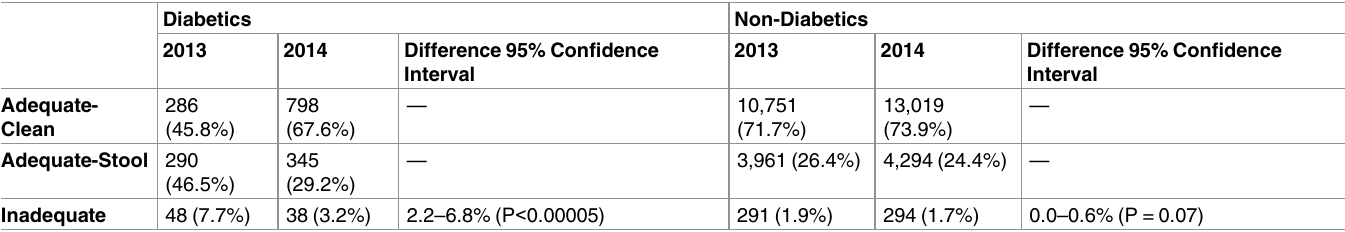
Other procedure outcomes for diabetics in 2014 and 2015 are shown in Table 4.